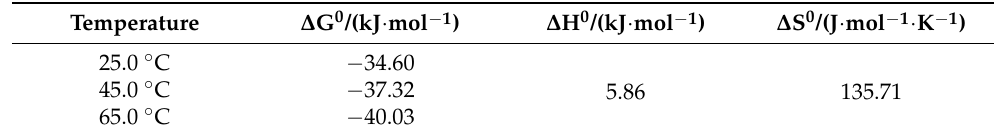
Table 5. Thermodynamic